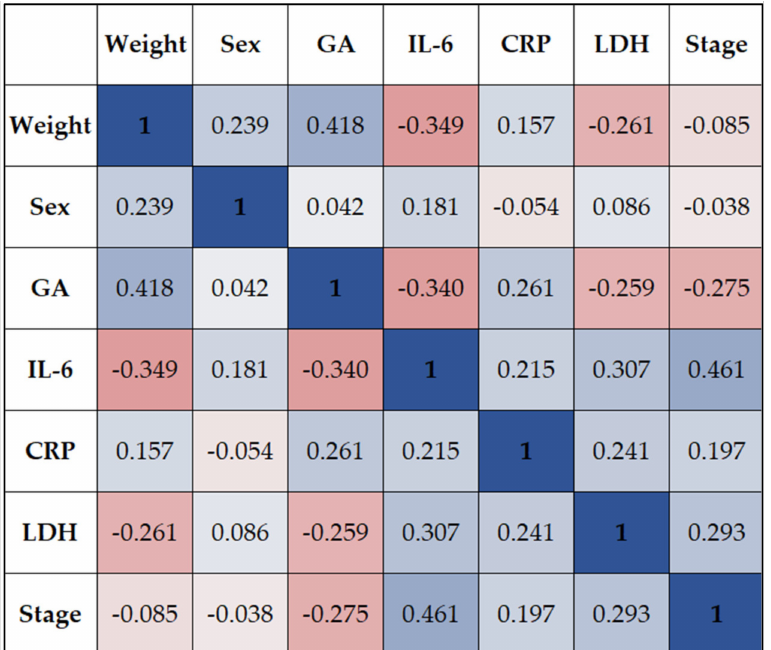
Figure 2. Correlation matrix; GA—Gestational Age; IL-6—Interleukin 6; CRP—C-reactive Protein; LDH—Lactate Dehydrogenase; Stage—Umbilical cord degree of